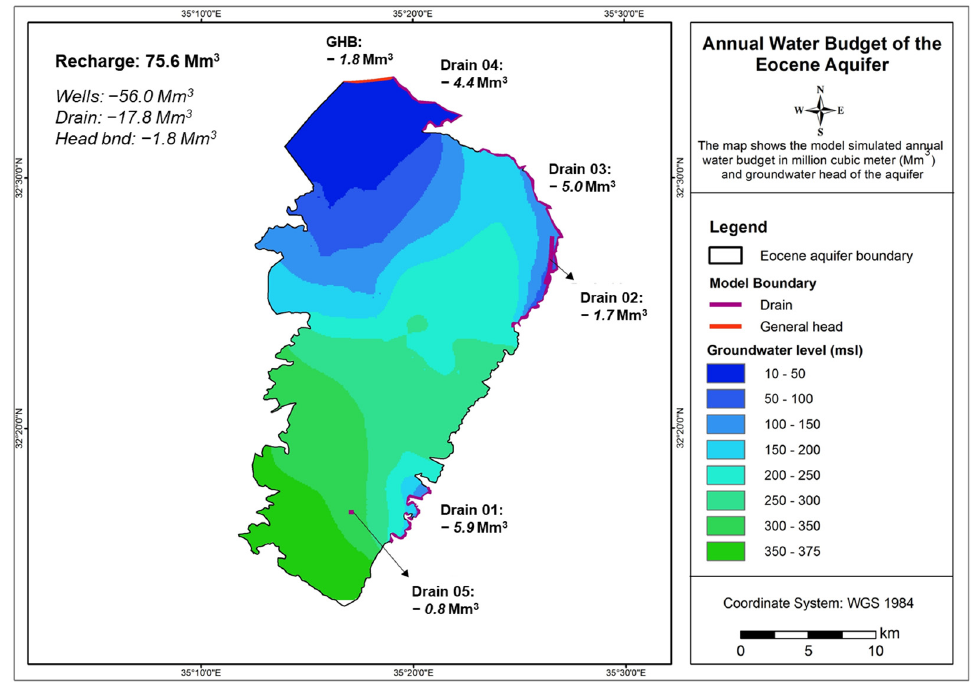
Figure 14. Simulated groundwater head distribution and water balance of Eocene aquifer for the existing conditions.